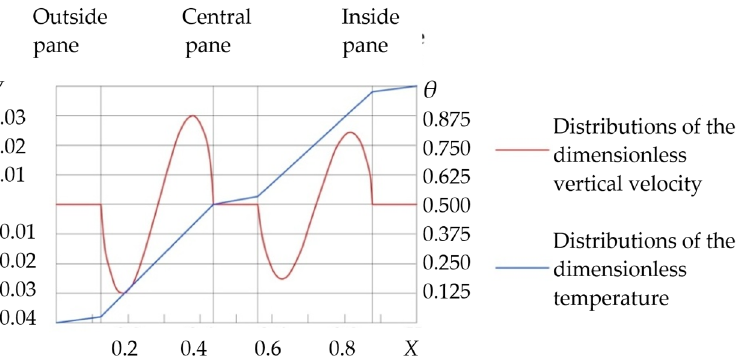
Figure 8. The distributions of the dimensionless vertical velocity and of the dimensionless temperature across the thickness of a triple-pane window (data obtained as a result of processing cited papers).